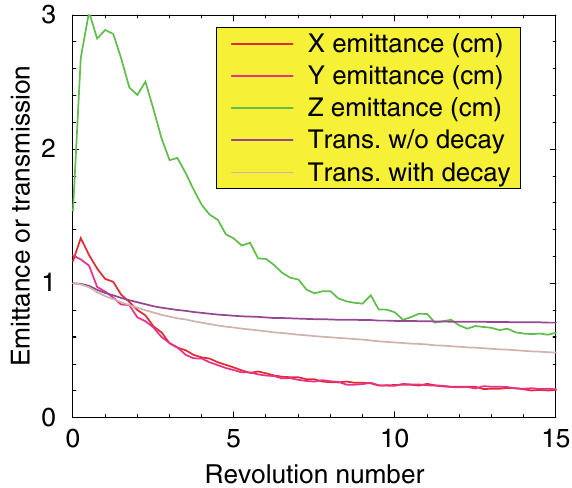
FIG. 36. (Color) Evolution of the beam emittance/transmission at the ring cooler. After 15 turns, the transverse emittances are reduced from 1.2 to 0.21 cm and the longitudinal emittance is reduced from 1.5 to 0.63 cm. The 6D emittance is therefore reduced from 2.2 to 0 : 028 cm 3 , giving a 6D cooling factor of 79. The transmission without decay is 71%, and the trans- mission with decay is 48%. The resulting merit factor is